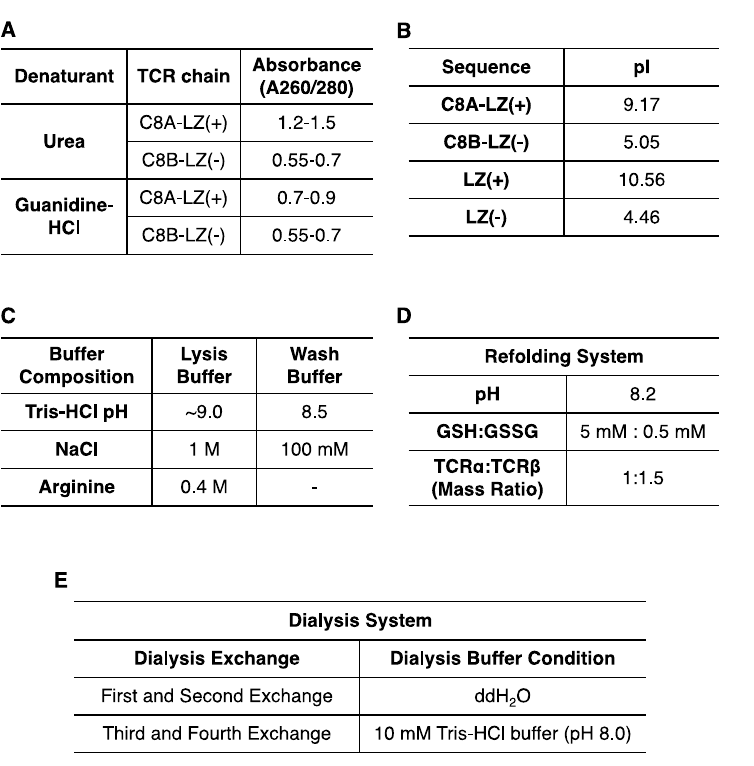
Figure 2. Optimization for TCR inclusion body expression, purification, and refolding. ( A ) Inclusion body purity varied with differing denaturants. ( B ) ProtParam measured pI values for each region of the refolded protein. ( C ) Composition of lysis buffer and wash buffer for TCR inclusion body purification. ( D ) Optimized TCR αβ refolding system. ( E ) Dialysis buffer conditions at each ex-